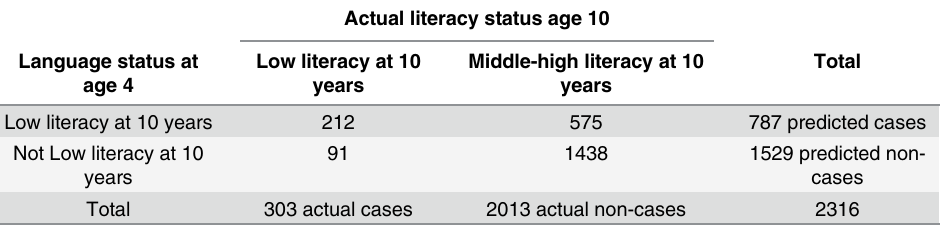
Table 7. Sensitivity-Specificity of Multivariate Logistic Model at probability cut-off of